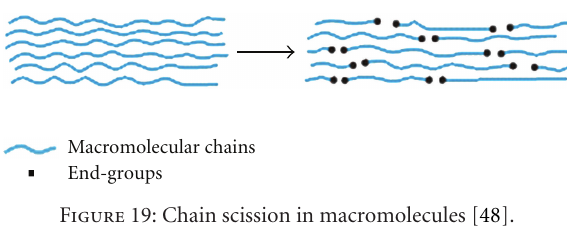
Figure 19: Chain scission in macromolecules [48].